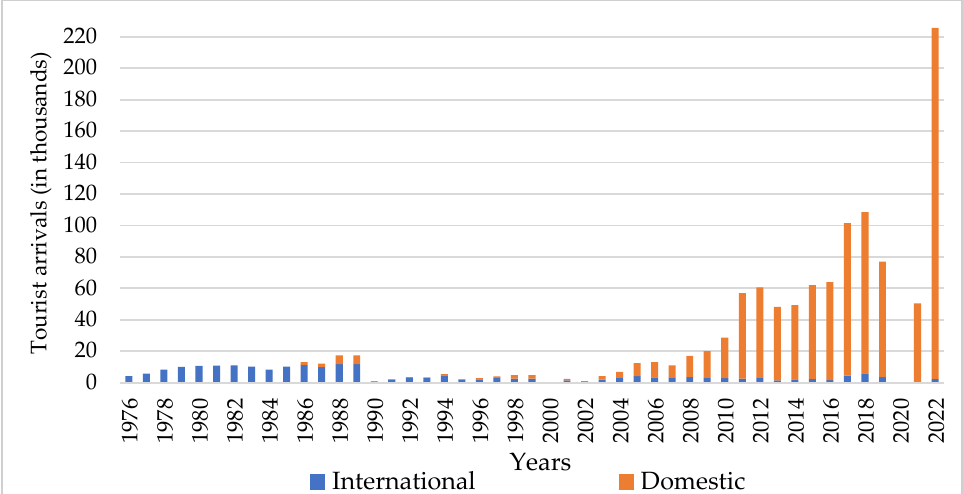
Figure 5. International and domestic tourist arrivals in Kargil, Ladakh from 1976 to 2022 (Source: District Tourism Department of Kargil, Union Territory of Ladakh).